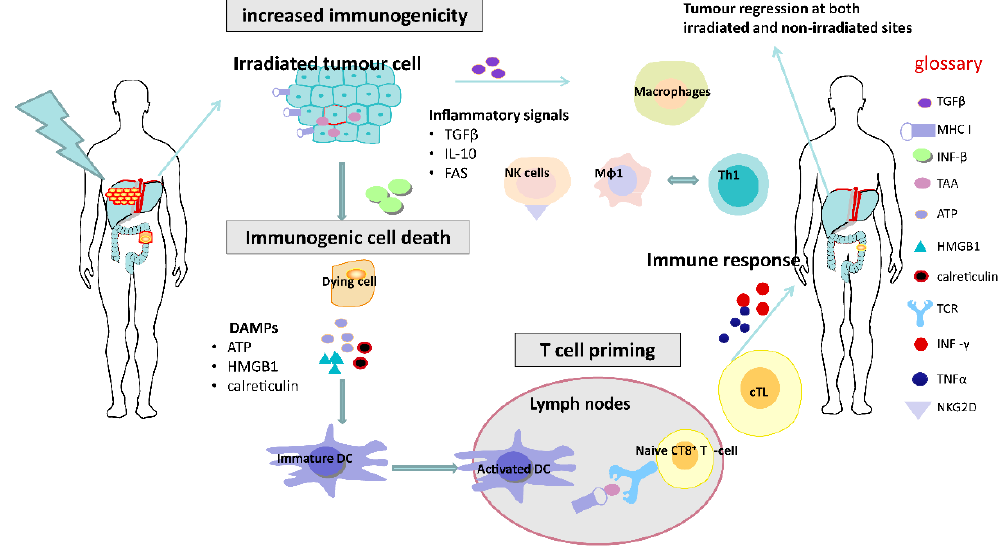
Figure 1. Immunostimulatory effects of radiotherapy. Radiotherapy can enhance the antigenicity of tumour cells by stimulating the induction of immunogenic cell death mediated by damage-associated molecular pattern molecules (DAMPs), which contributes to DC maturation and T cell priming. Activated cytotoxic T cells (cTL) in the blood can cause systemic immune responses, potentially resulting in tumour regression outside the irradiated field. DC, dendritic cell; M φ 1 cells, macrophage type-1 cell; Th1 cell, T helper type 1 cell.